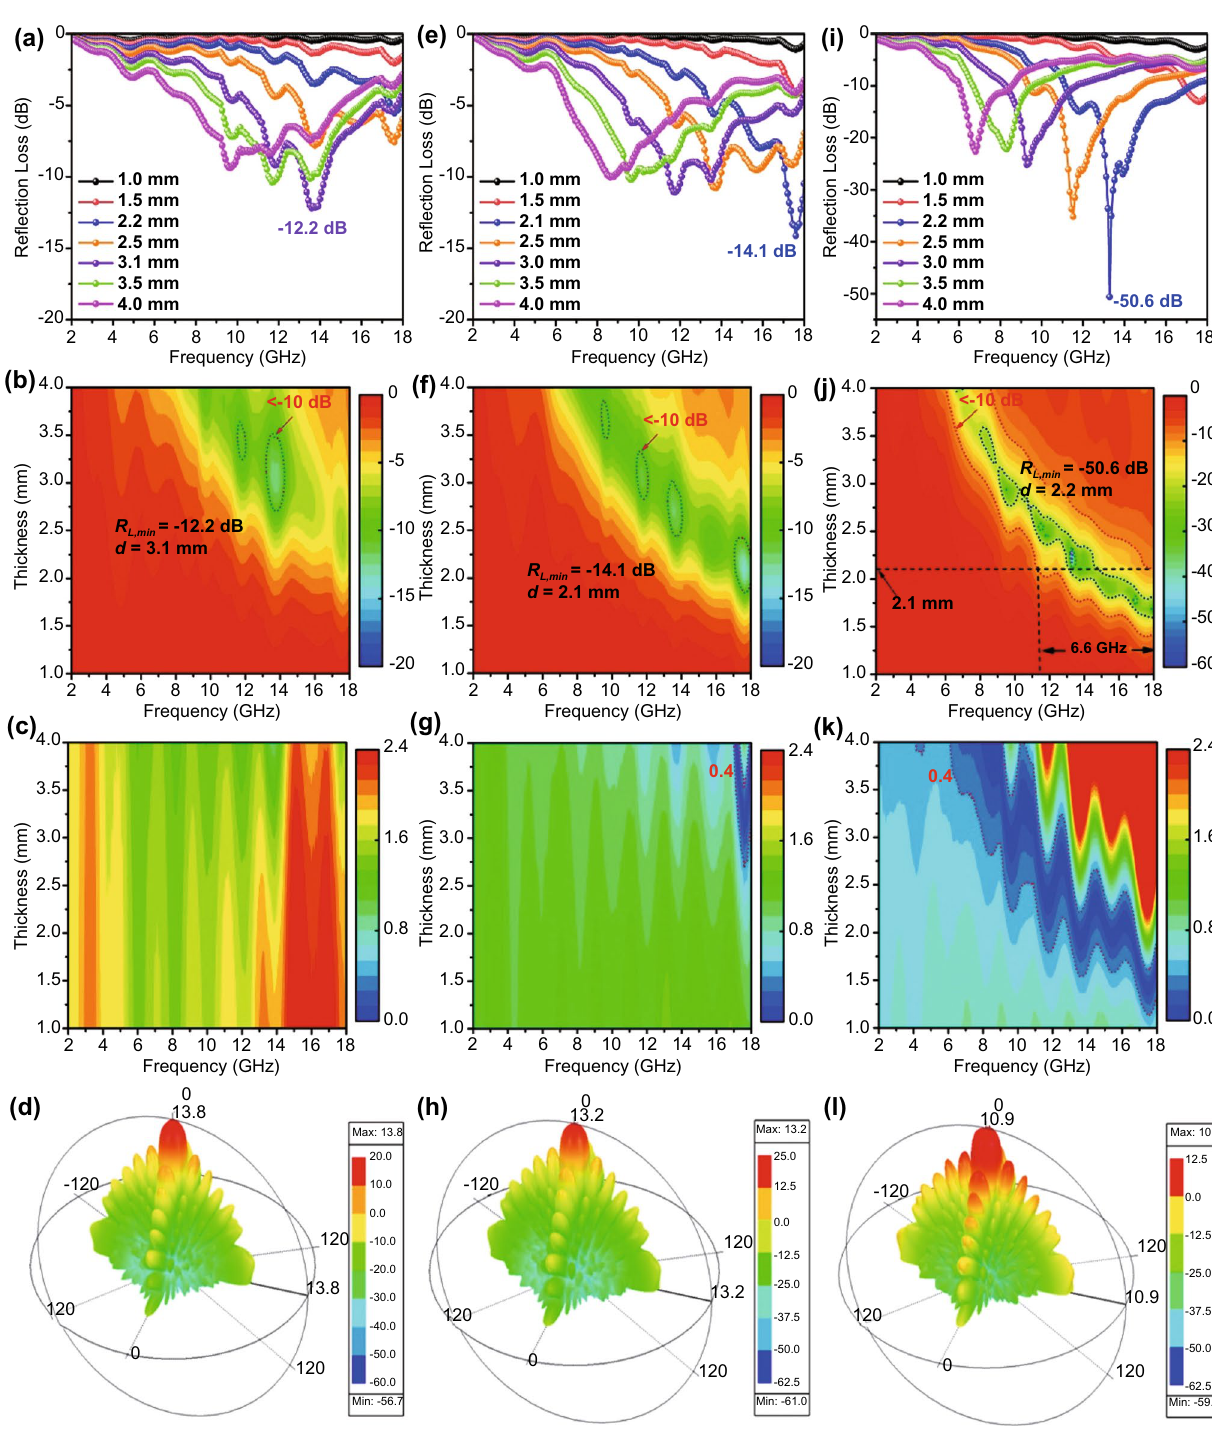
Fig. 4 R L values, 2D projection, Δ maps, and 3D spherical coordinate diagrams of HFSS simulation analysis for a–d SiO 2 @C, e–h HCNs, and i‑l Co/Co 3 O 4